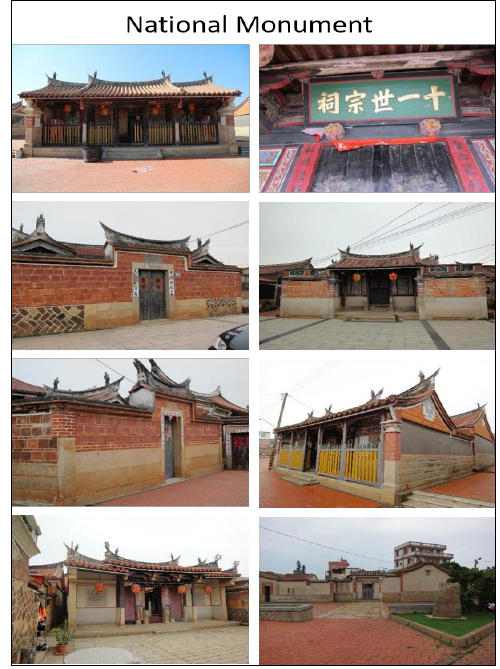
Figure 5. Qiong Lin Settlement